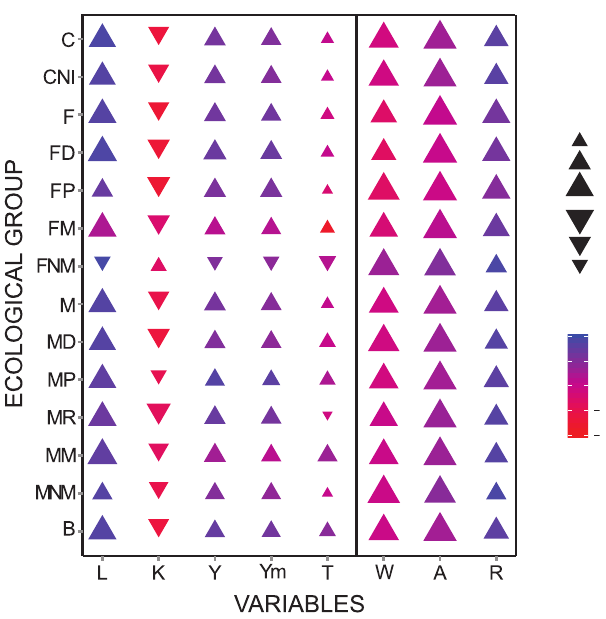
Figure 5. Relationships between canonical loadings of the first and second canonical dimensions for the sets of dependent and independent variables for all species, freshwater species, marine species and various ecological groupings. Correlations with the first dimension are expressed by triangles (positive values) and reverse triangles (negative values). Correlations with the second dimension are expressed by colour scale. AOO: area of occupancy (number of 1 6 1 u grid cells from which a species was recorded); EOO: extent of occurrence (EOO, number of grid cells of 1 u along the maximum latitudinal range 6 number of grid cells of 1 u along the maximum longitudinal range of each species). Fish characteristics: L: maximum length; K: growth rate; T: trophic level; Ym: age at first maturity; Y: life span. Ecological categories: C: complete data set; CNI; complete data set excluding species subjected to be introduced; F: all freshwater species; FD: freshwater demersal; FP: freshwater pelagic; FM: freshwater migratory; FNM: freshwater non migratory; M: all marine species; MD: marine demersal; MP: marine pelagic; MM: marine migratory; MNM: marine non migratory; B: brackish.